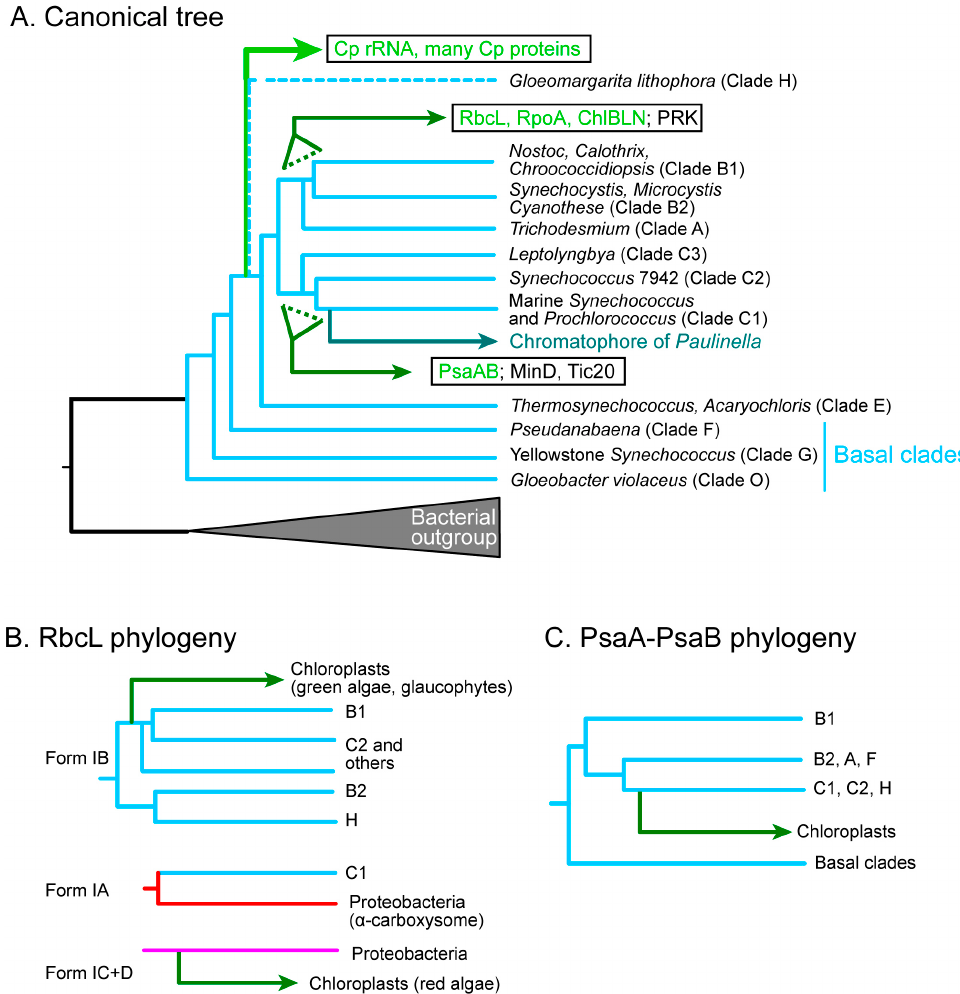
Figure 3. Schematic phylogenetic trees showing different origins of chloroplast enzymes (or RNA) within the cyanobacterial diversity. ( A ) Canonical phylogenetic tree of cyanobacteria and chloroplasts. Various clades of cyanobacteria are shown according to [53,54]. Chloroplast-encoded proteins and RNA are shown in green. Nuclear-encoded chloroplast proteins are shown in black. The clade names are taken from [53]. According to [54], G. lithophora is sister to the main chloroplast clade represented by chloroplast rRNA. For simplicity, Clade H is used for G. lithophora . The posi- tions of branching of RbcL and PsaA/B are shown with dotted lines because they do not match exactly with the canonical tree. ( B ) Different origins of chloroplast and cyanobacterial RbcL. ( C ) Probable origin of PsaA and PsaB. As explained in the text and Supplementary Materials, the phy- logeny of PsaA and PsaB is very difficult. This diagram, which is consistent with previous results, is still a plausible hypothesis among many other alternatives. Different line colors are used to show different lineages such as cyan for cyanobacteria and green for chloroplast. Colored protein names are used to show chloroplast-encoded proteins.